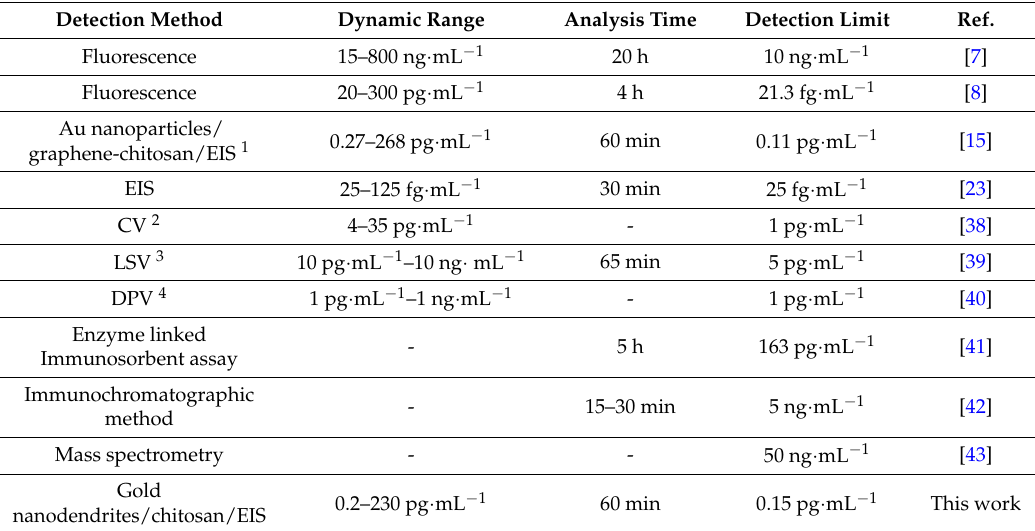
Table 3. Comparison of different methods for the determination of